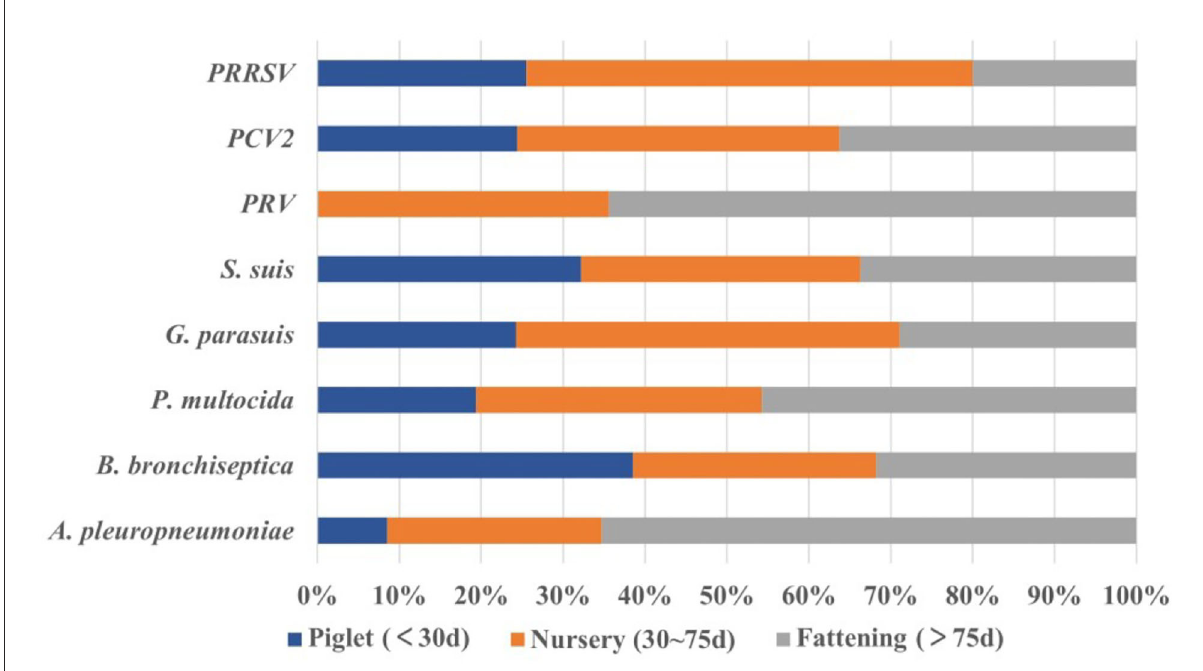
FIGURE5 The proportion of pathogens among different stages (age). Piglets ( n = 91), nursery pigs ( n = 622), and fattening pigs ( n =